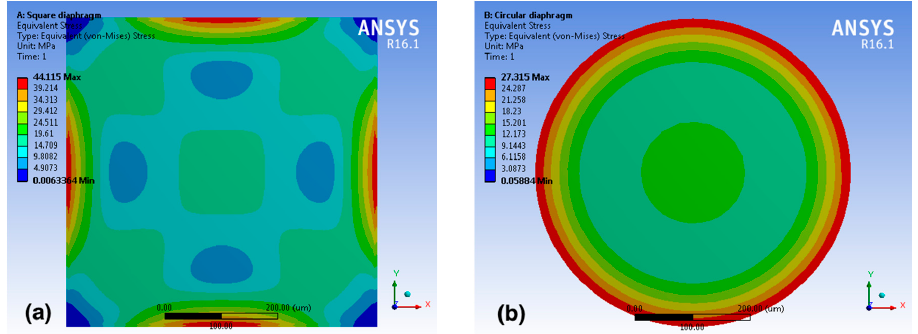
Figure 4. Contour plot of the Von Mises stress distribution on ( a ) a square and ( b ) a circular